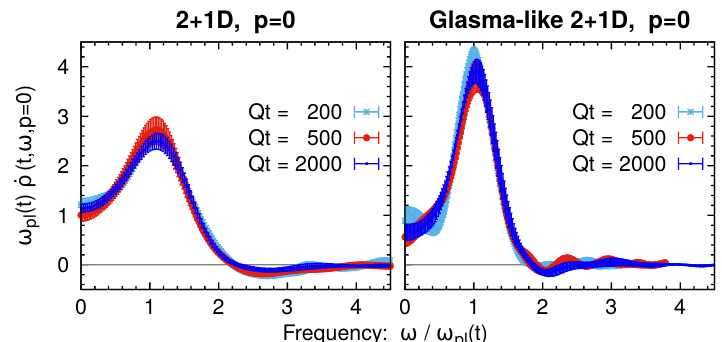
Figure 10 . The dotted spectral function of gluonic excitations as a function of frequency for vanishing momentum ω ˙ ρ ( t, ω/ω =0) at different times, rescaled by the plasmon frequency such pl pl , p that they are made dimensionless. All curves fall on top of each other, showing the correlation functions follow a self-similar evolution with the only parameter ω ( t ) pl